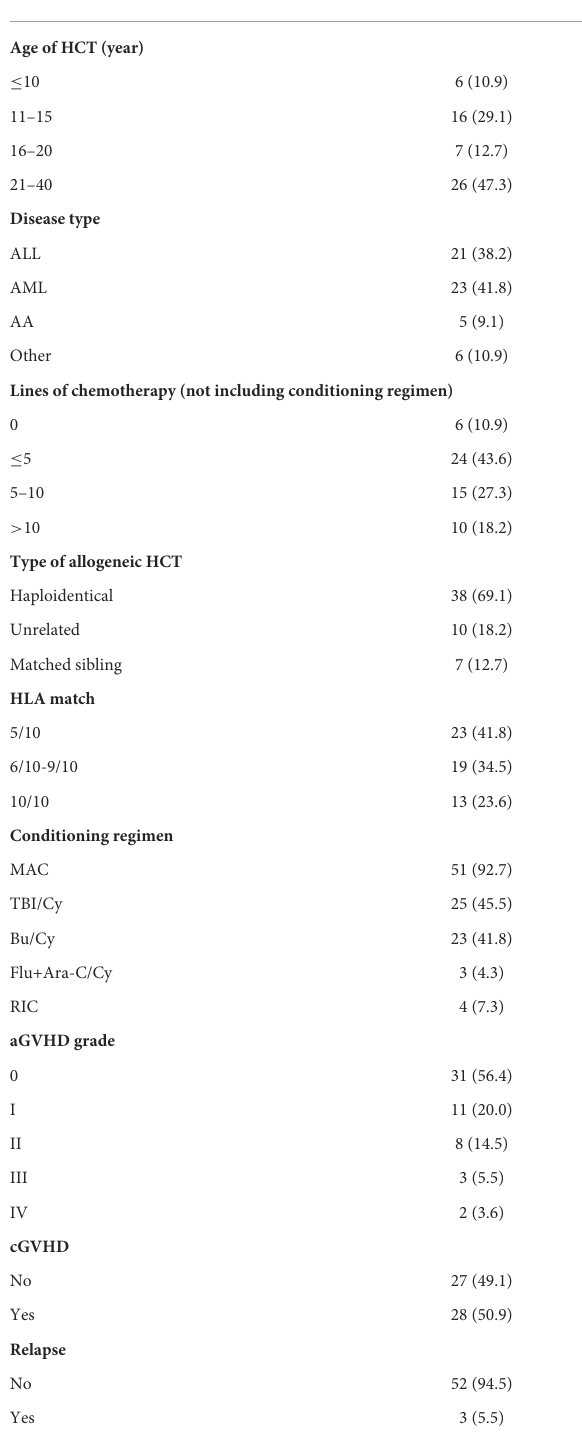
TABLE 1 Baseline characteristics of the patients ( N =